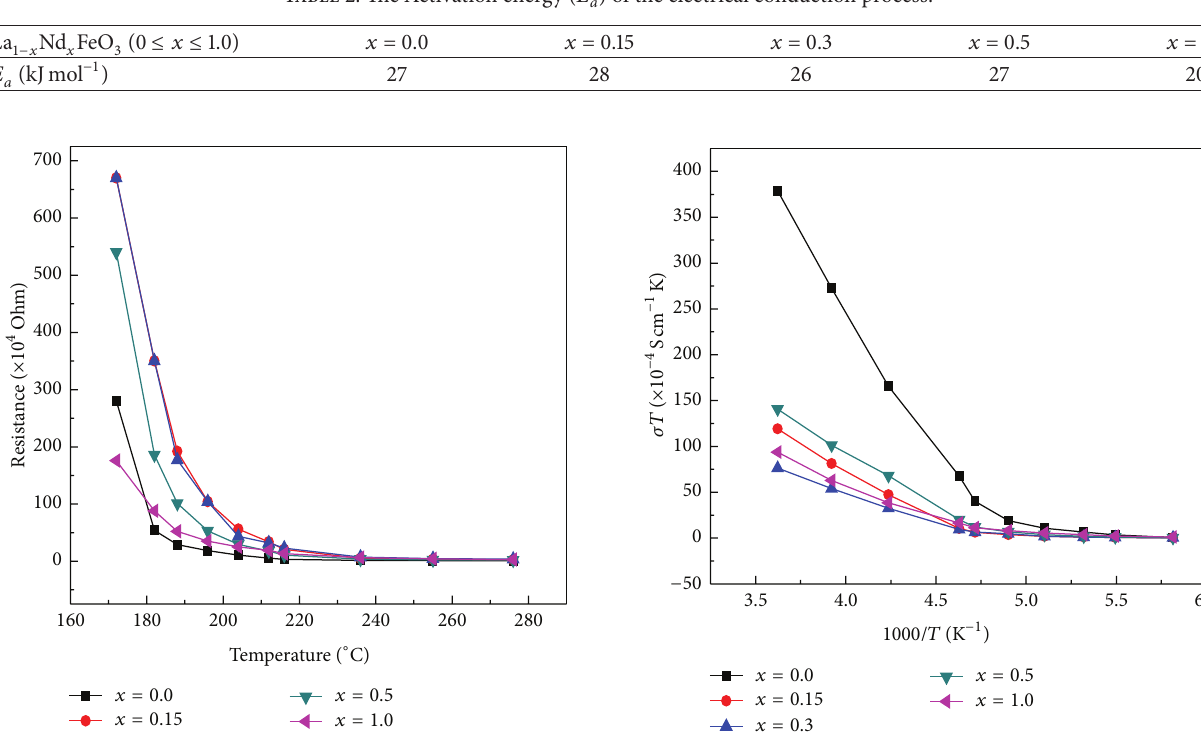
Table 2: The Activation energy ( 𝐸 𝑎 ) of the electrical conduction process.